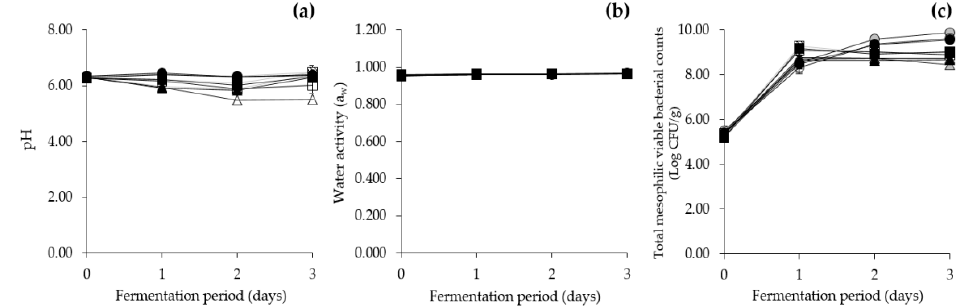
Figure 3. Physicochemical and microbial properties during Cheonggukjang fermentation at various temperatures. ( a ) pH, ( b ) water activity, ( c ) total mesophilic viable bacterial counts. • : 25 ◦ C, (cid:4) : 37 ◦ C,